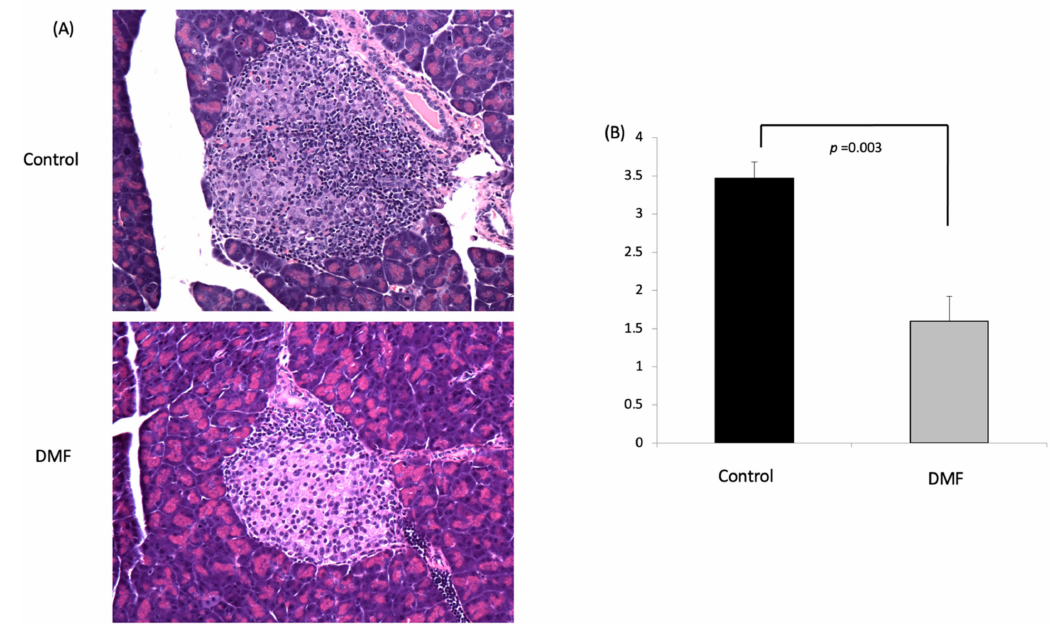
Figure 4. DMF treatment protects pancreatic islets and reduces insulitis in accelerated model of NOD mice. ( A ) Rep- resentative images of H&E-stained pancreatic section from DMF-treated group and control group; magnification: x200. Compared to DMF-treated group, severe lymphocyte infiltration in the islets was found in control group. ( B ) DMF treatment significantly reduced insulitis score compared to control group ( n = 4).